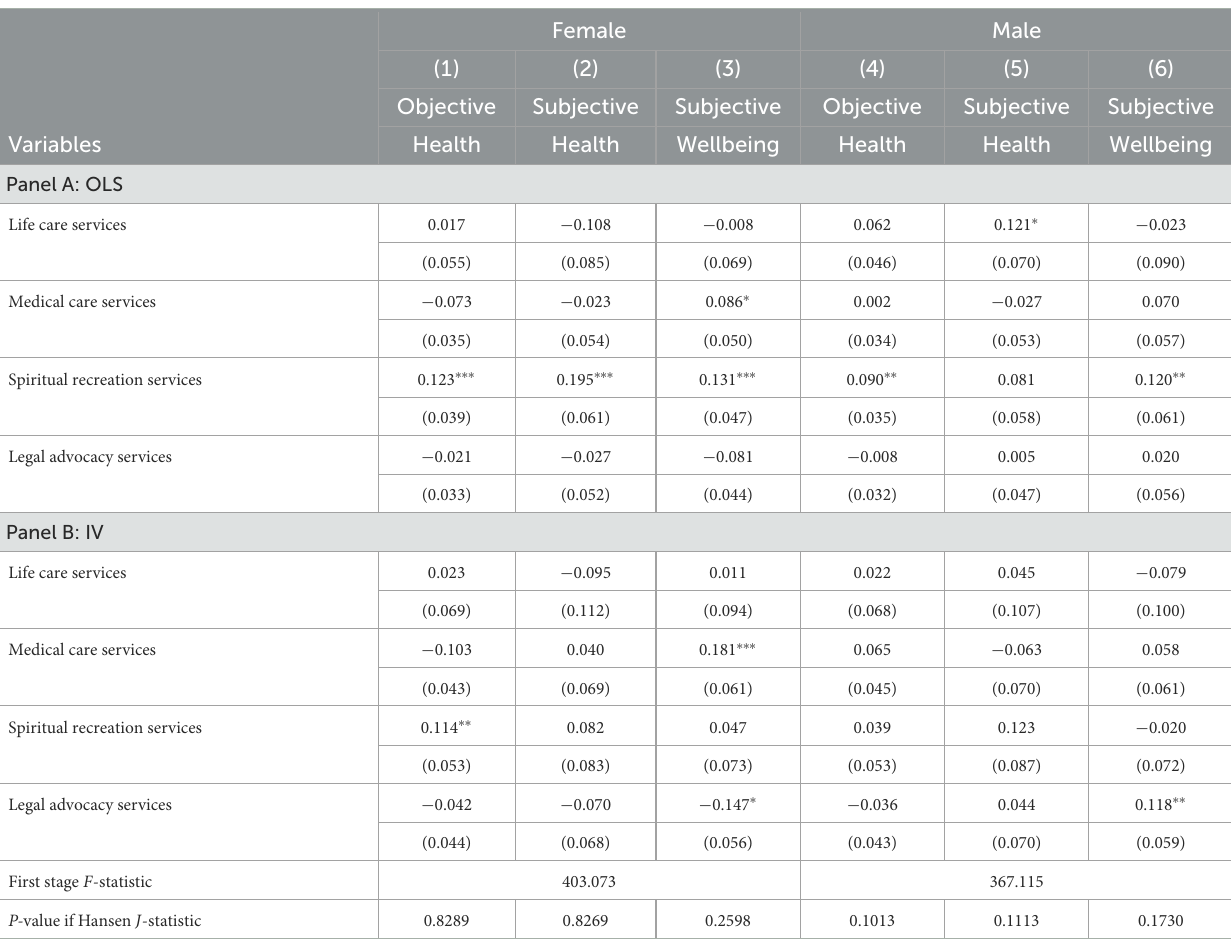
TABLE 8 Heterogeneous effect by